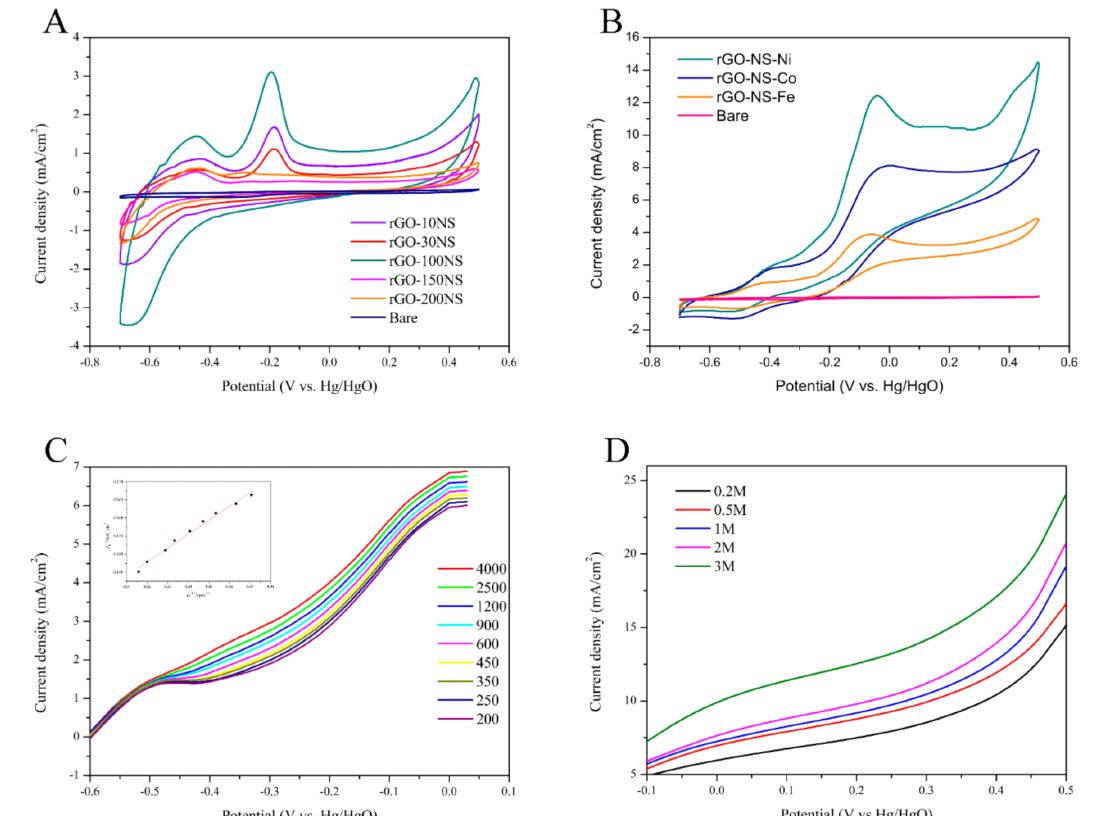
Figure 2. ( A ) Cyclic voltammetry (CV) curves of rGO-10NS, rGO-30NS, rGO-100NS, rGO-150NS, and rGO-200NS in 0.6 M KOH and 0.2 M glucose solution (50 mV/s scan rate, 25 ◦ C). ( B ) CV curve of rGO-NS-M in 0.6 M KOH and 0.2 M glucose solution ( C ) Rotating disk electrode (RDE) curves for glucose solution at 0.2 M on rGO-NS-Ni in 0.6 mol/L KOH solution, at 25 ◦ C. Scan rate: 50 mV/s. ( D ) Linear sweep voltammetry (LSV)curve of rGO-NS-Ni in different concentrations of glucose solution (50 mV/s scan rate, 25 ◦